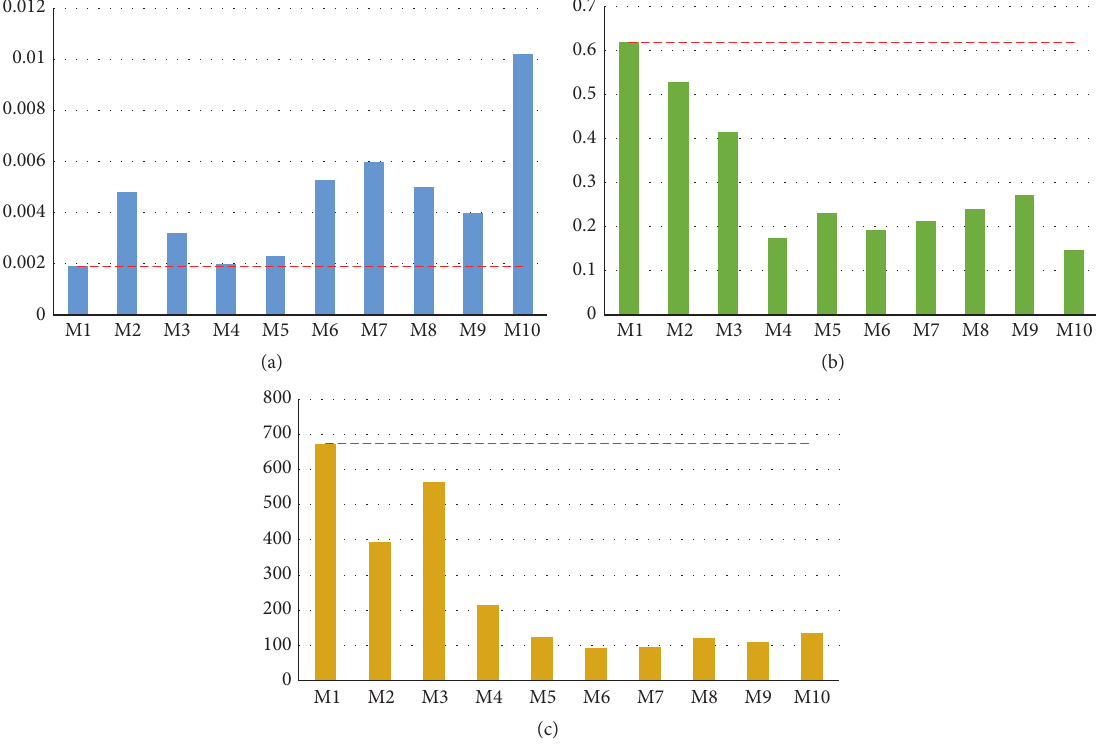
Figure 7: Comparison of scatter parameter values based on different methods: (a) 𝑆 𝑤 , (b), 𝑆 𝑏 , and (c) 𝑆𝑆